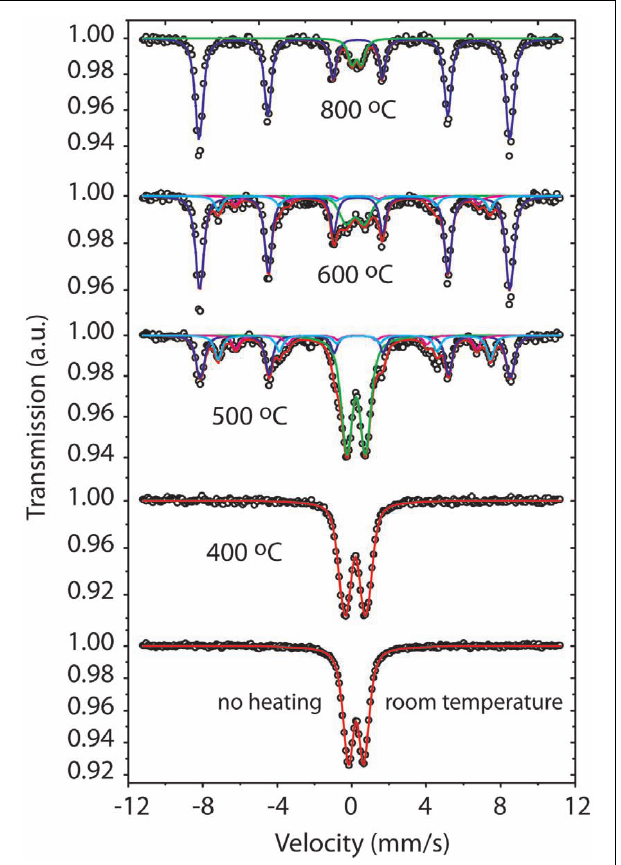
FIGURE 10 |The Mössbauer spectra show that before thermal treatment the sample is represented by a (superparamagnetic) Fe 3 + doublet. After thermal treatment at 400˚C the material still remains a superparamagnetic phase similar to the initial material.The spectra above 500˚C have the presence of sextets, they represent the conversion of Fh SRO to a more stable phase, hematite.